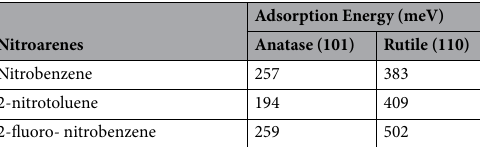
Table 2. The computed adsorption energies of nitroarenes over (101) of anatase, and (110) of rutile TiO 2 . The adsorption energies correspond to the stabilization energy of the nitroparenes over the constructed